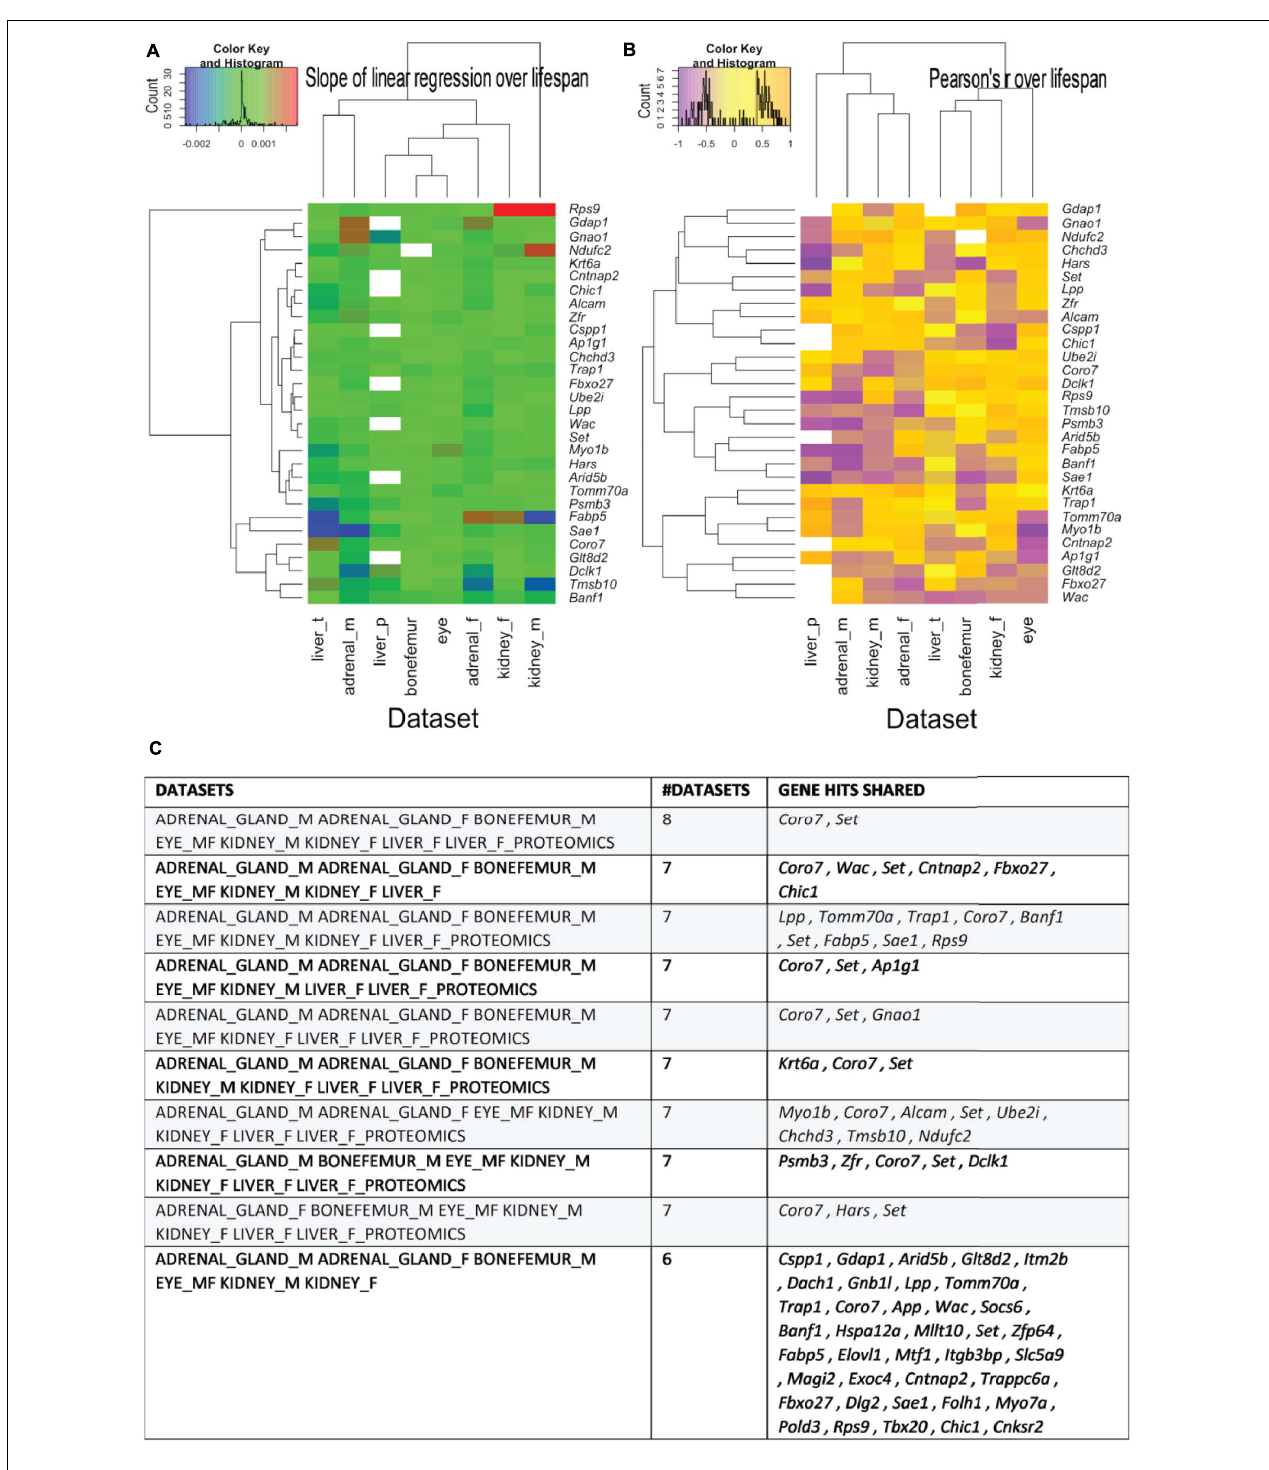
FIGURE 5 | The most shared genes correlating with lifespan. (A) Heatmaps showing the clustered common longevity genes by both the values of the linear regression over median strain lifespans, respectively. (A) Pearson’s correlation coefficient over the median strain lifespans (B) and tissue of origin (A,B) . The commonality is here intended as being present in the source -omics data with a Pearson’s r absolute value greater than 0.4 and in more than one data set. Particularly, the genes used for generating the heatmaps are the ones that are present in most tissues and are shown in panel C , with the indication (left column) of the dataset they come from. See Supplementary Table 6 for a more detailed listing of the